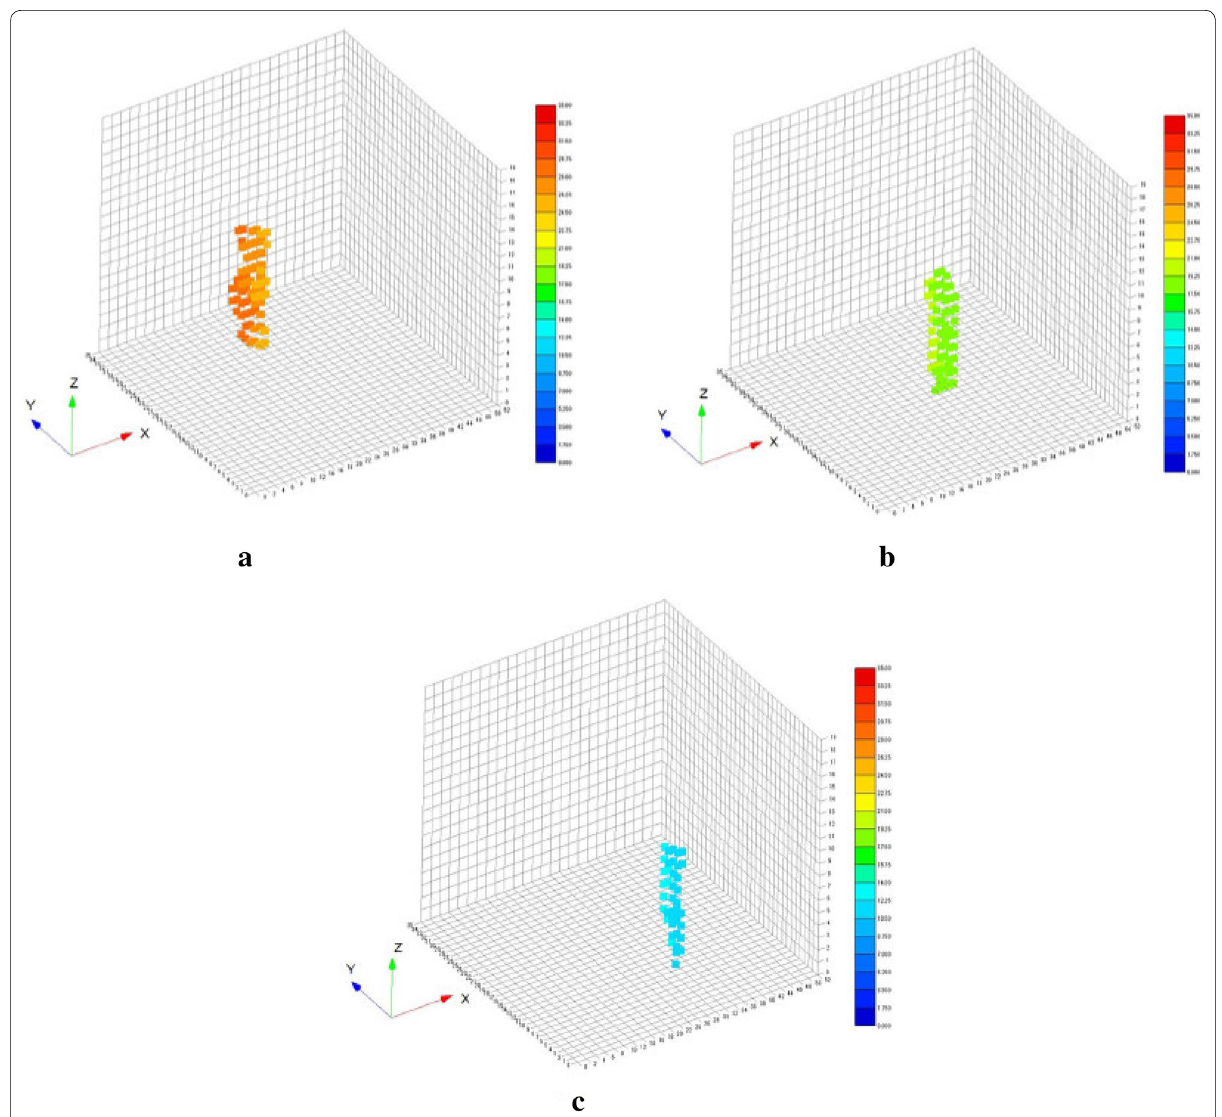
Fig. 6 Result of labeling and mean-shift clustering of point cloud. a Person 1, b Person 2, c Person